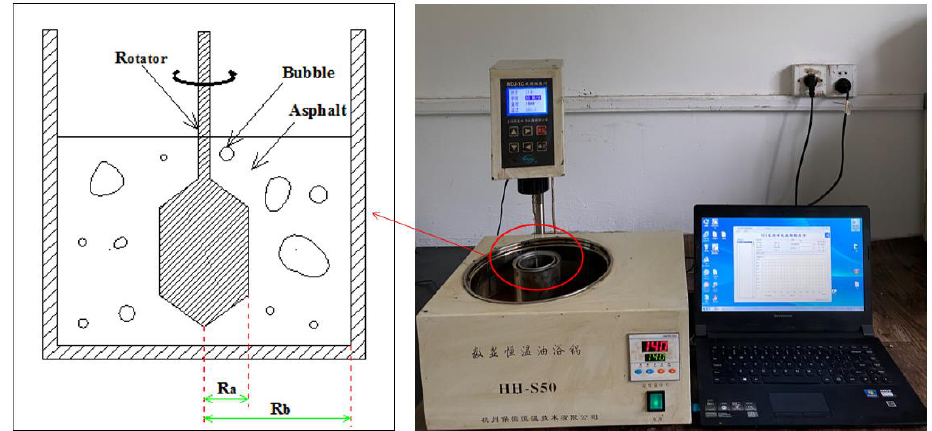
Figure 1. Test schematic diagram ( left ) and modified rotational viscosity (RV) test ( right ).